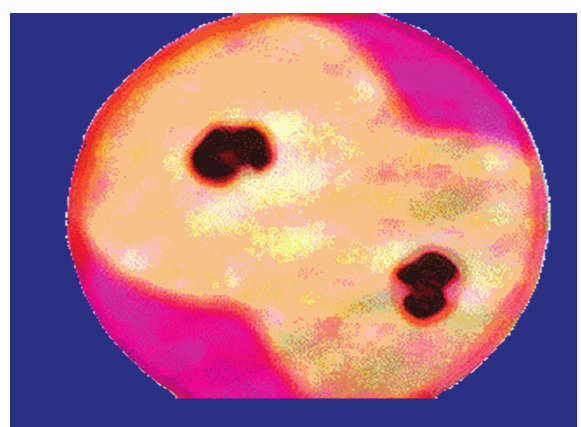
Figure 1: Plate showing zone of clearance around colony by